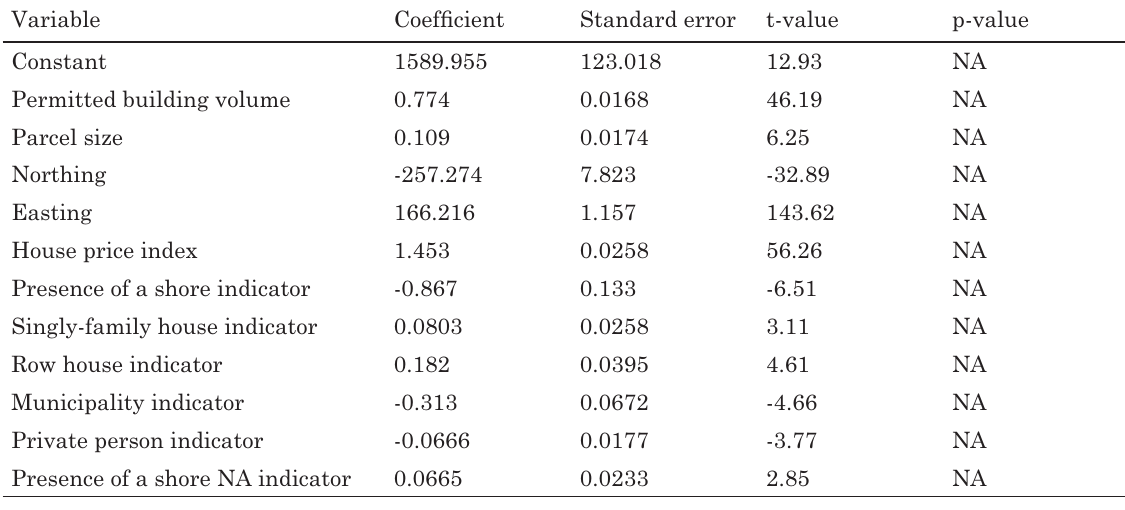
Table 3. Fit and hedonic prices from the